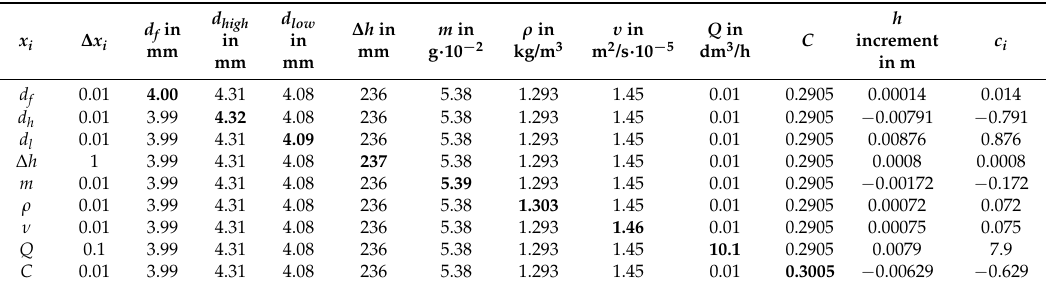
Table A1. Calculation of the sensitivity coefficients c i for VA meter (3–30) dm 3 /h. The values in bold denote parameters that are incremented in a given row.